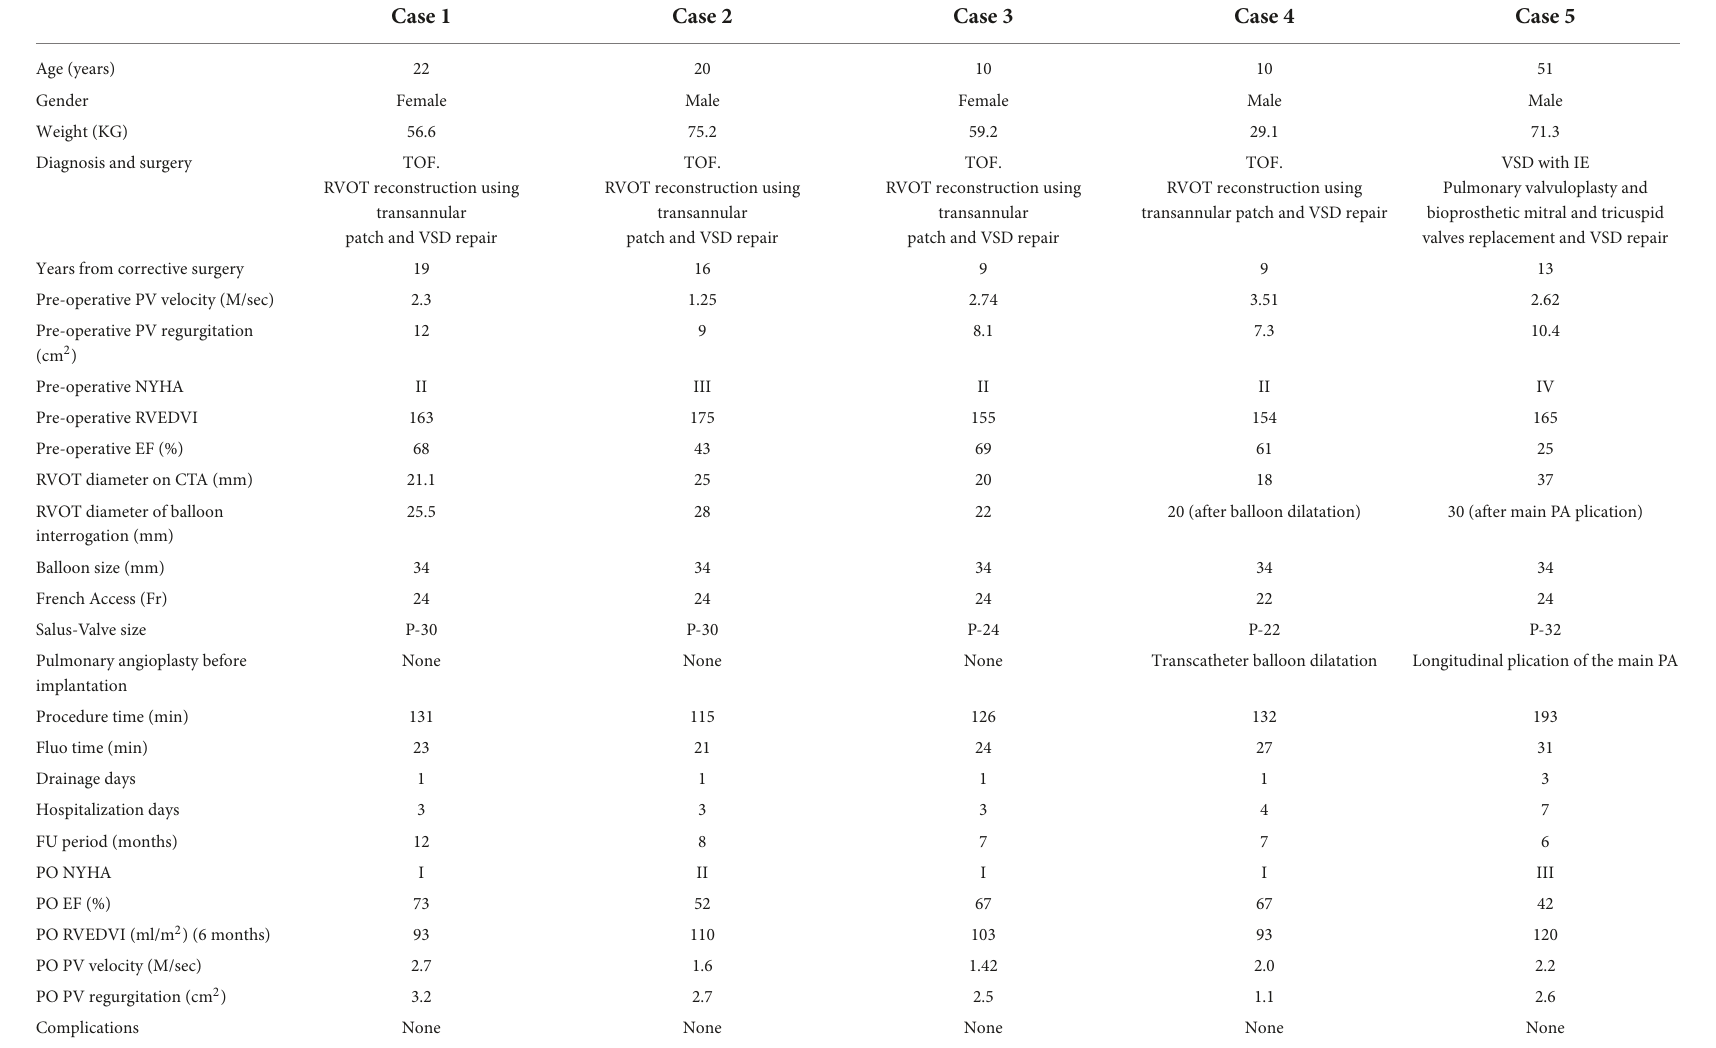
TABLE 1 Patients characteristics and